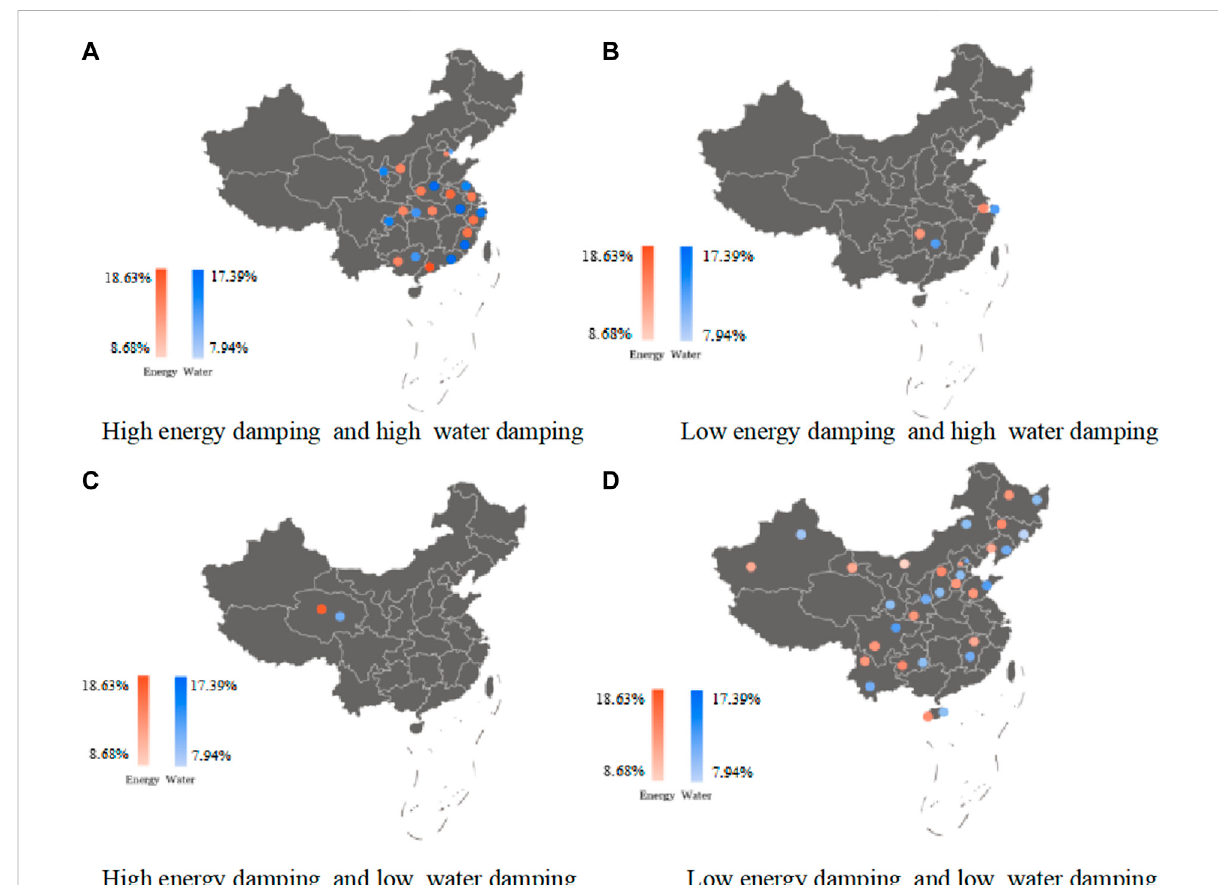
FIGURE 3 Spatial distribution patterns of the growth drag. (A) High energy damping and high water damping. (B) Low energy damping and high water damping, (C) High energy damping and low water damping. (D) Low energy damping and low water